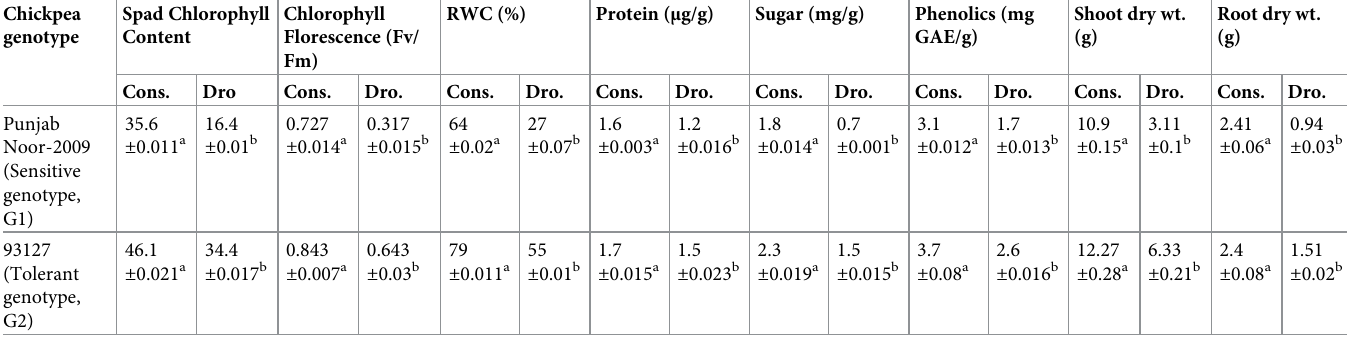
Table 1. Chlorophyll content and chlorophyll florescence (Fv/Fm ratio) of two chickpea genotypes under consortium and drought condition after 25 days of stress imposition. Chickpea Spad Chlorophyll genotype